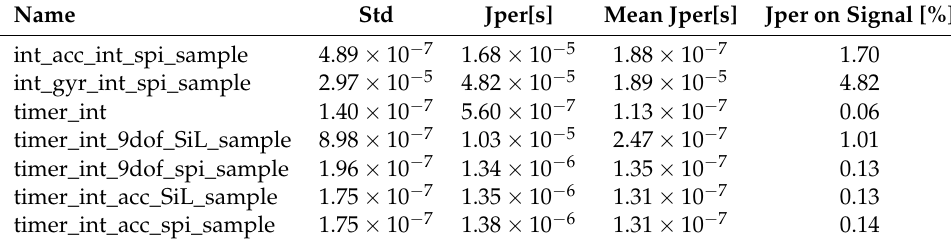
Table 8. Periodic Jitter with optimization